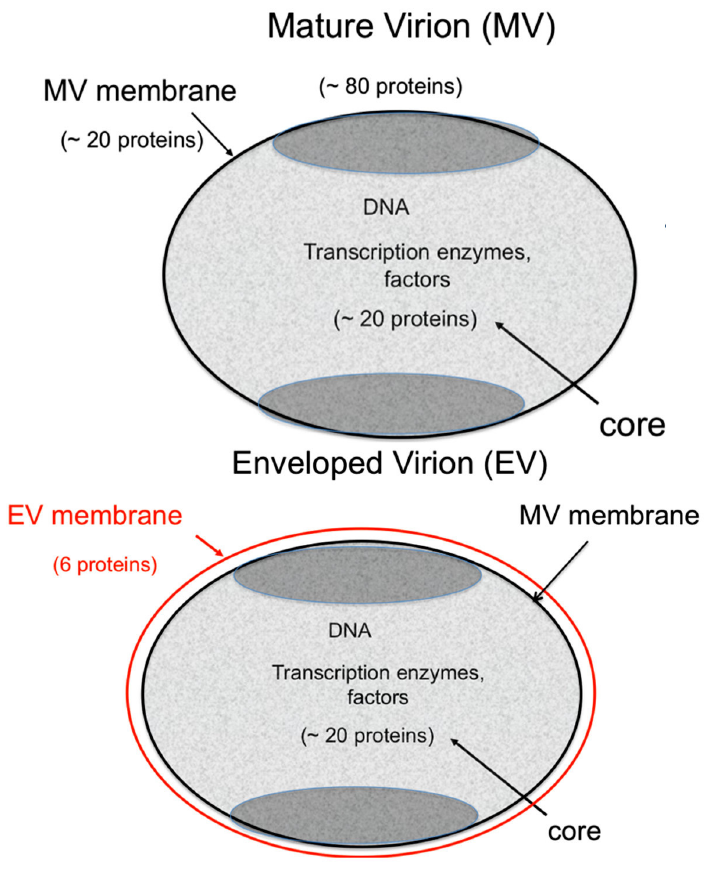
Figure 1. Two major forms of infectious virions. The mature virion (MV) contains more than 80 proteins and consists of a nucleoprotein core surrounded by a lipid membrane ( black ) with about 20 proteins. Approximately 20 proteins within the core are devoted to synthesis and modification of mRNA. The enveloped virion (EV) consists essentially of a MV with an additional membrane ( red ) containing about 6 proteins distinct from those in the MV